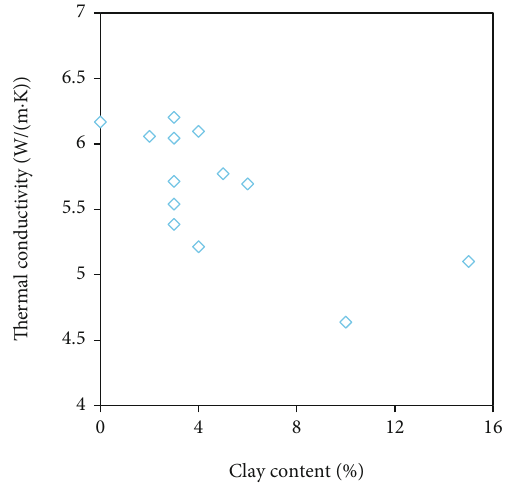
Figure 14: Thermal conductivity of dolomite with varying clay